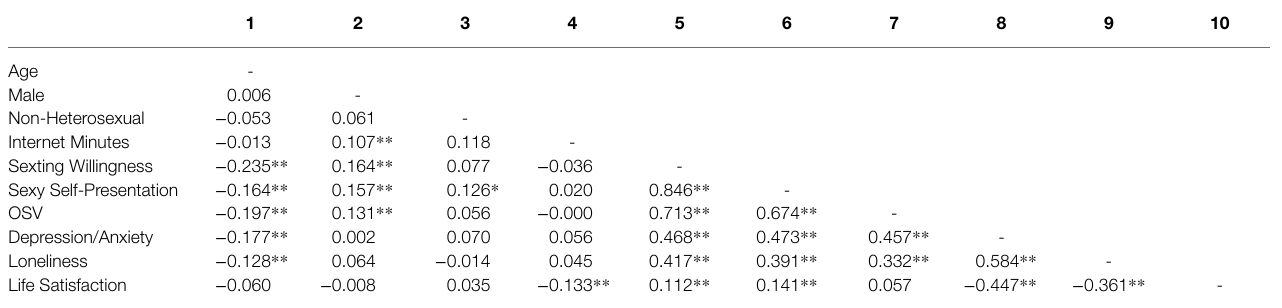
TABLE 3 | Cross-sectional correlations between latent and observed variables in the cross-lagged